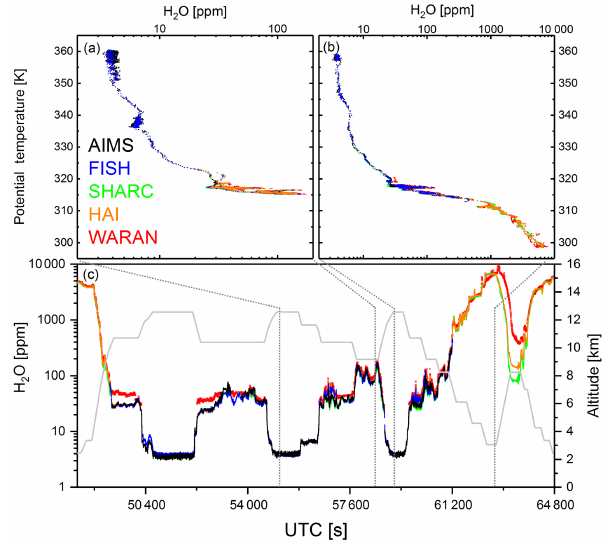
Figure 2. Water vapor molar mixing ratio measurements for the re- search flight on 3 April 2014. AIMS (black) and SHARC (green) measured in situ gas phase H 2 O, while FISH (blue), HAI (orange) and WARAN (red) measured total water. Panels (a) and (b) are pro- files of H 2 O in situ measurements plotted against potential tem- perature, showing the descent between 54904 and 58522s and the descent between 59139 and 61398s, respectively. Panel (c) is the time series of the complete flight including the HALO flight altitude in